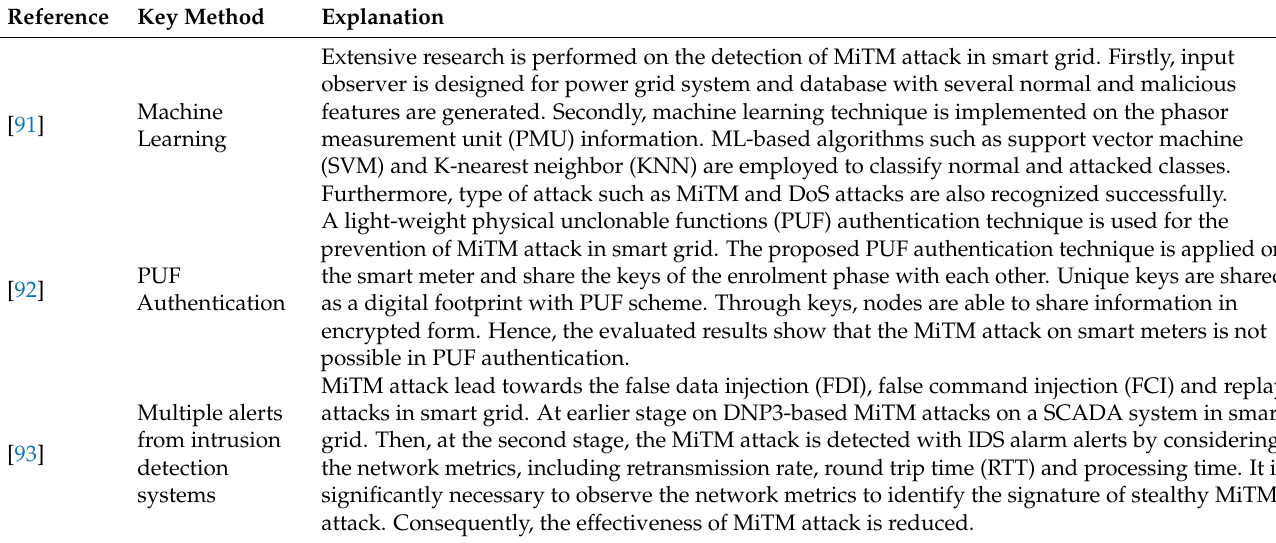
Table 5. Methods and countermeasures to defend against MiTM